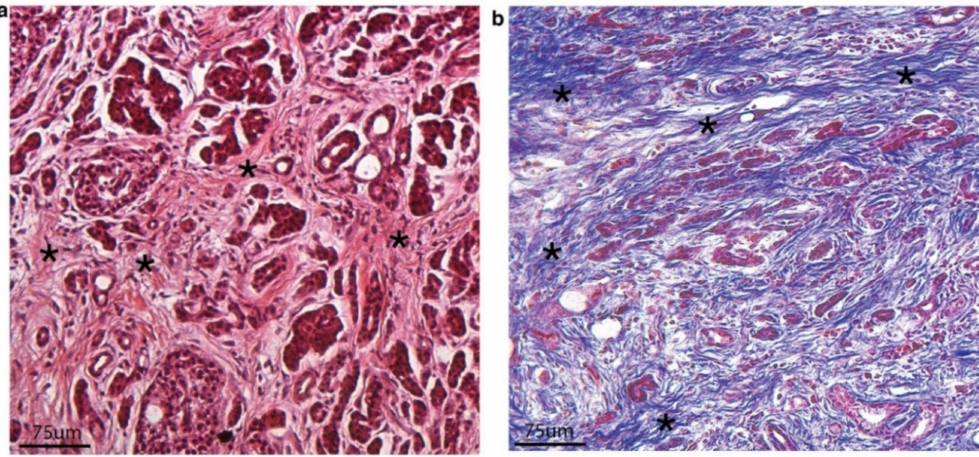
( a ) Hematoxylin and Eosin (H&E stain) of a surgically resected pancreatic ductal adenocarcinoma showing small and medium glands with irregular morphology embedded in dense, desmoplastic stroma (highlighted with black asterisks). ( b ) Trichrome stain of surgically resected pancreatic ductal adenocarcinoma highlighting severe desmoplasia and dense matrix that appears as linearized ribbons of blue stain (collagen fibers) (highlighted with black